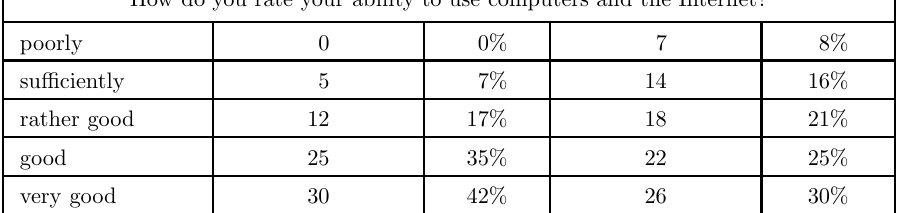
Table 1. Subjective assessment of the ability to use a computer and the Internet in the surveyed groups of students e-learning method (n = 72) traditional method (n = 87) No of persons % No of persons